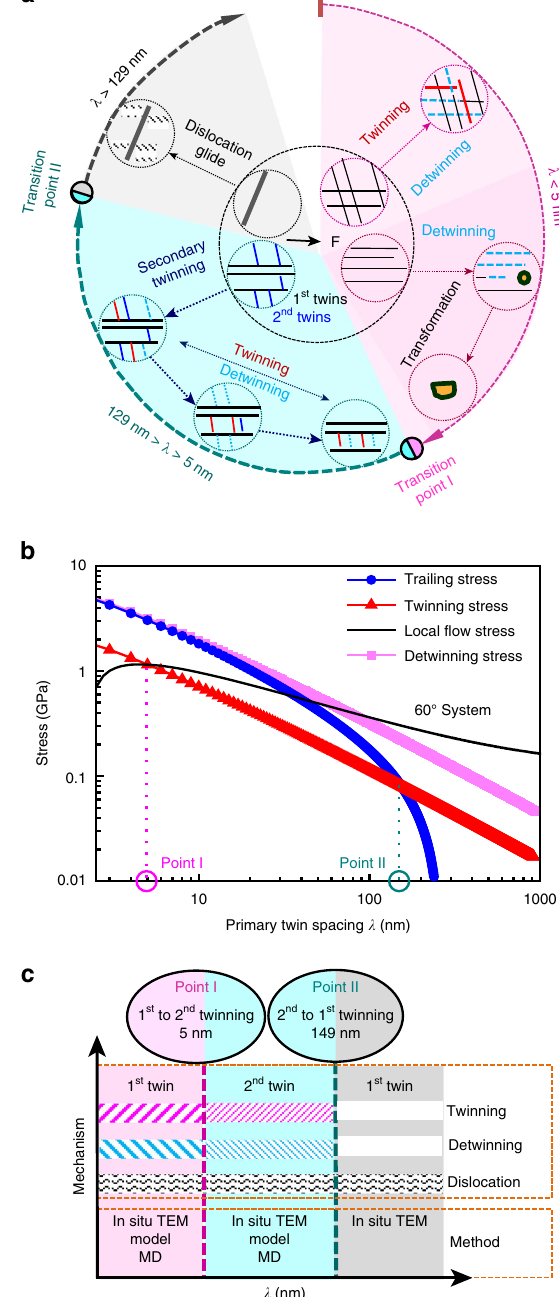
Supplementary Figure 3. NTs intersected with fi rst twins at an